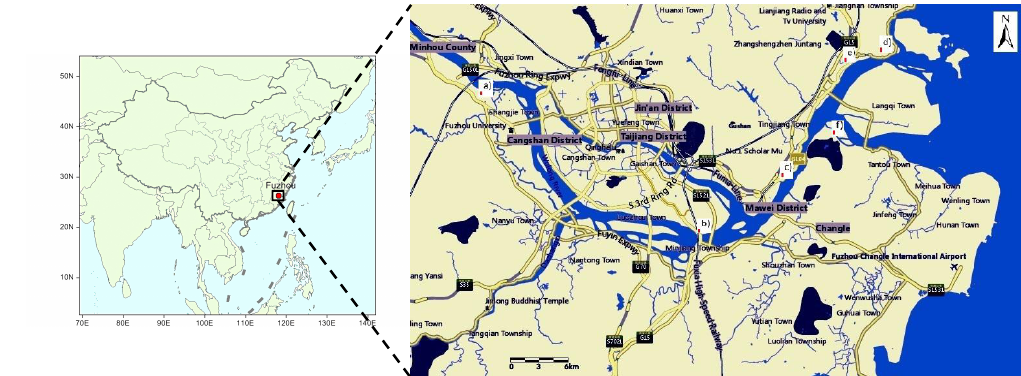
Figure 1. Location of the study area, it depicts the river network, the bifurcation and confluence of the lower Min River reaches. a) Shangjie; b) Xiadou; c) Minan; d) Changmen; e) Guantou;